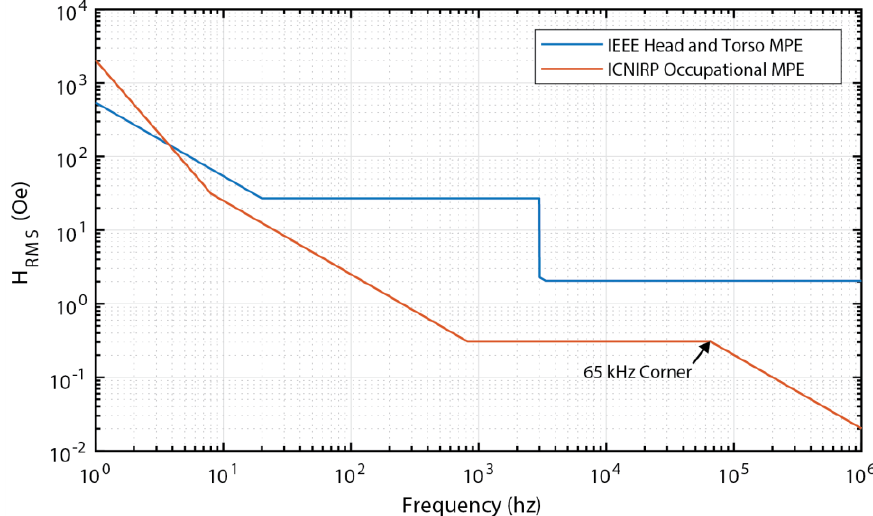
Figure 14. Allowable magnetic MPE levels for IEEE and ICNIRP standards. Adapted from [22–24].